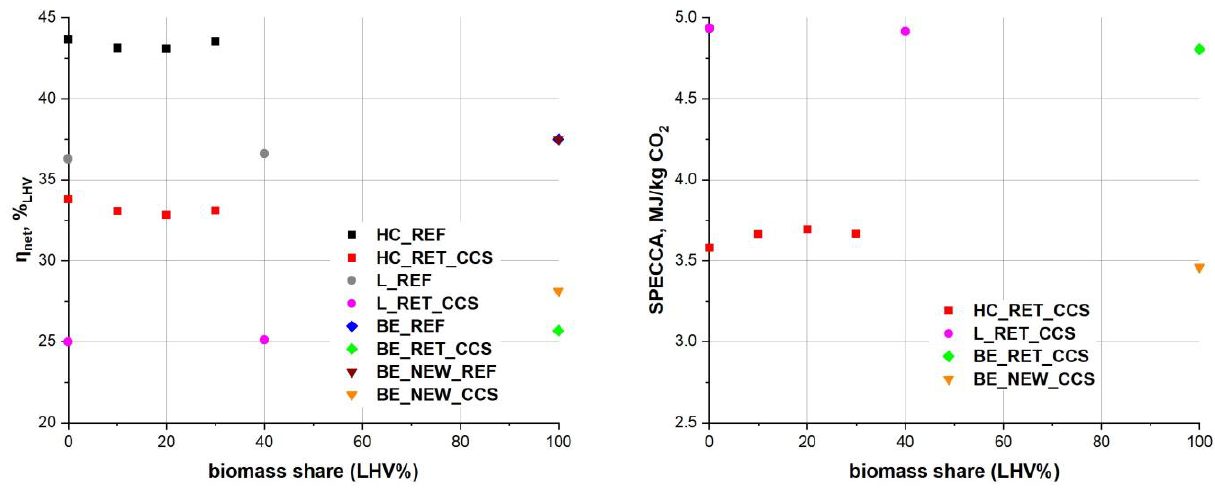
Figure 5. Energy assessment results.